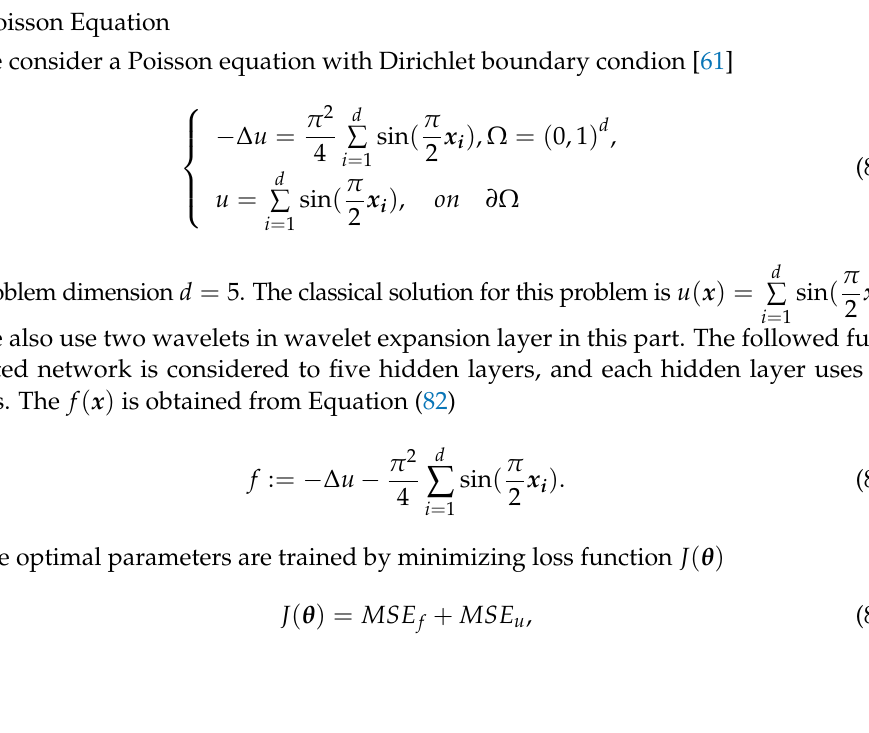
Figure 22. Results of Equation (77) at different time instants. ( a – c ) Exact solution, numerical solution, and numerical error at t = 0.01. ( d – f ) Exact solution, numerical solution, and numerical error at t = 0.05. ( g – i ) Exact solution, numerical solution, and numerical error at t =